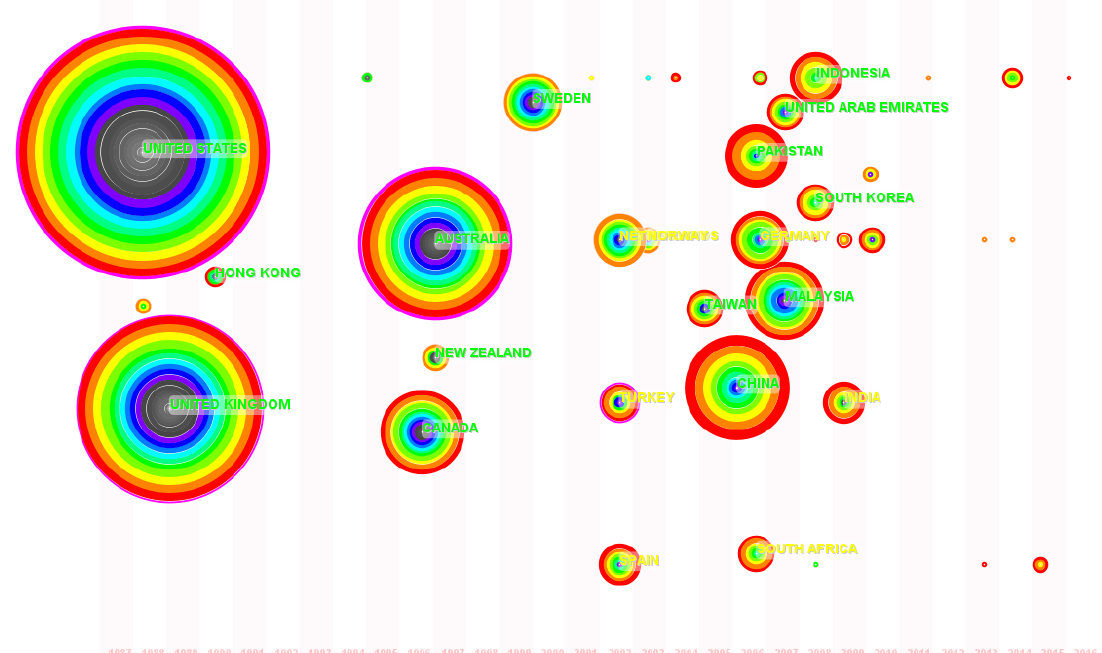
Figure 4. Country/region collaboration network: a timezone view. Table 1. Top 10 countries/regions based on the number of publications .